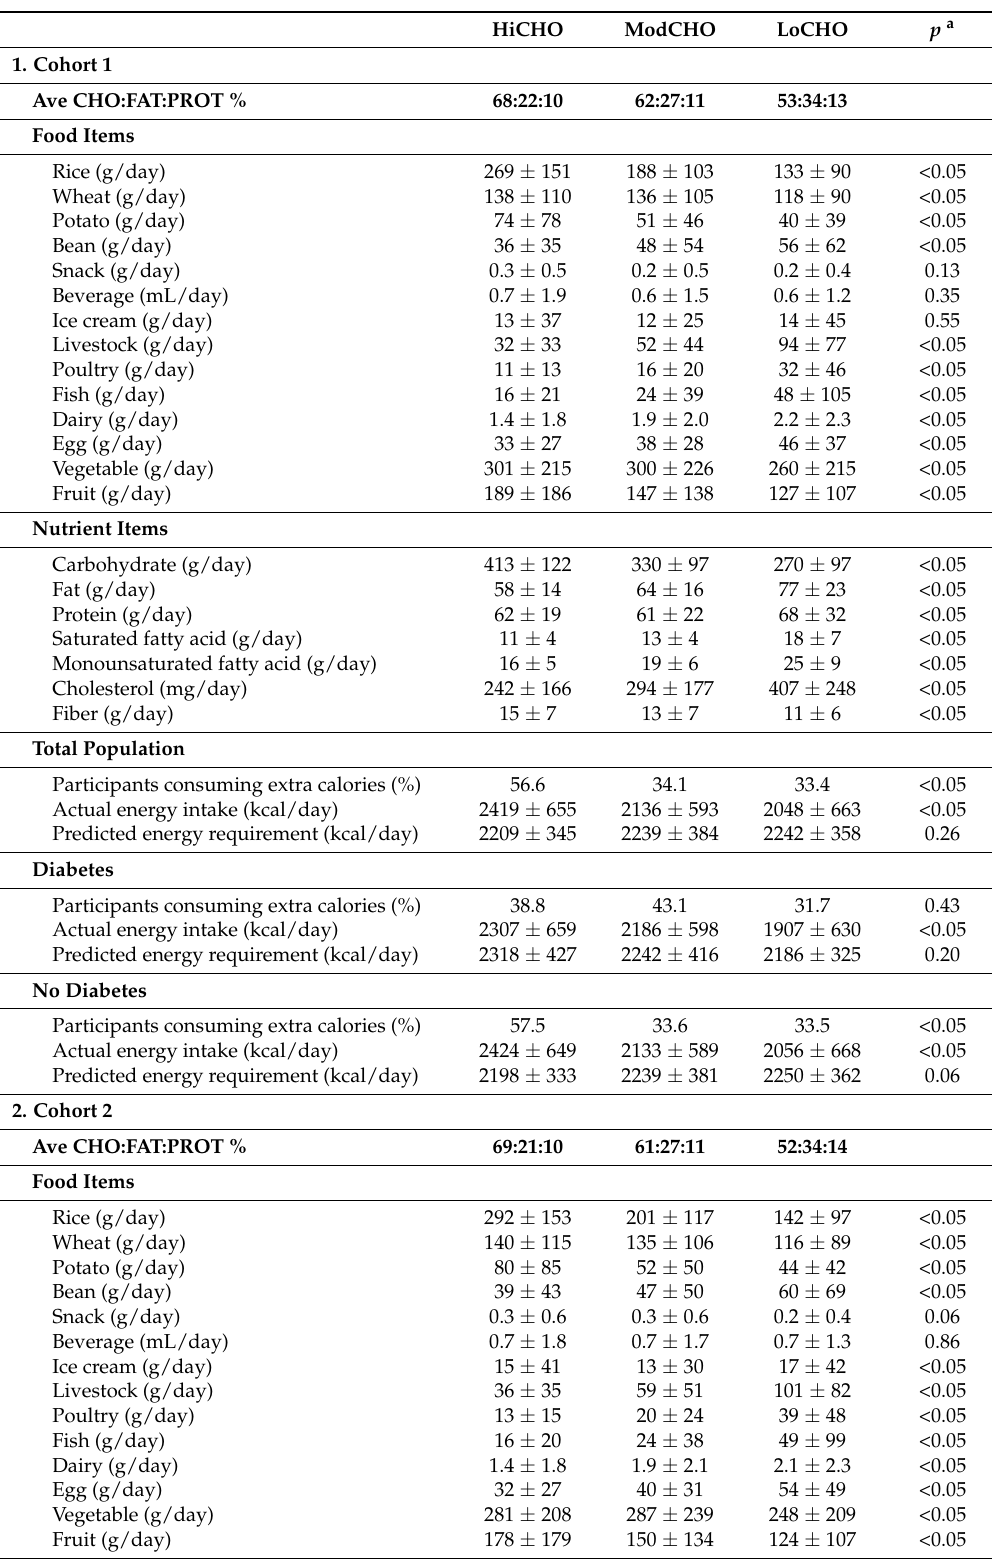
Table 2. Nutrition information across tertiles of low-carbohydrate, high-fat and high-protein diet scores in the Harbin People’s Health Study (Cohort 1, 2008–2012) and the Harbin Cohort Study on Diet Nutrition and Chronic Non-Communicable Diseases (Cohort 2,